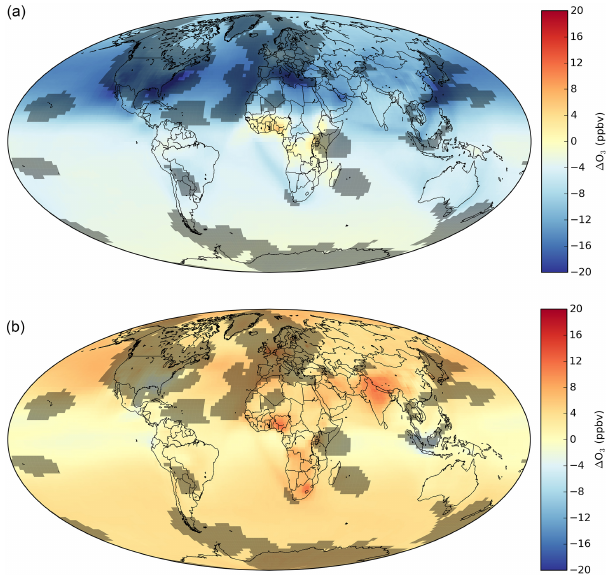
Figure 7. Maps showing the mean trend across ACCMIP models in annual mean surface ozone from 2005–2010 to 2095–2110 for sce- narios (a) RCP2.6 and (b) RCP8.5, following Young et al. (2013). Shaded regions are areas that are covered by the footprints of ozone sites; light regions do not have ozone